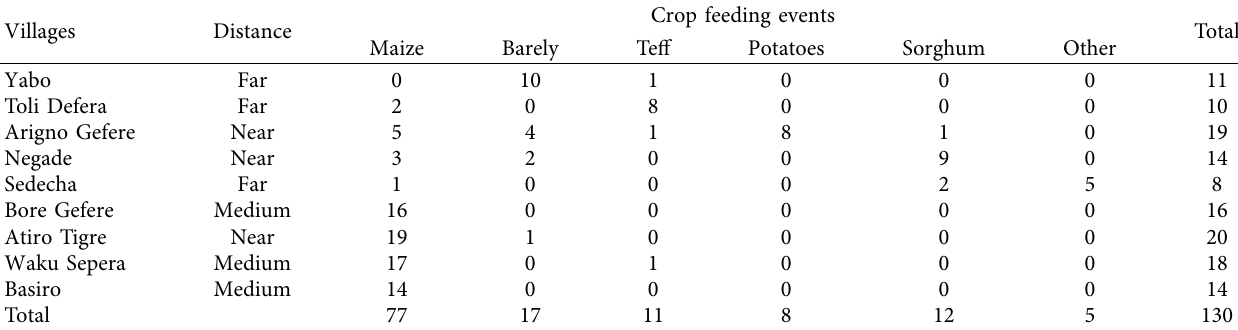
Figure 1: Map of the study area (source: from GIS satellite by Taso Table 1: Te types of crops fed on by primates in the study villages.